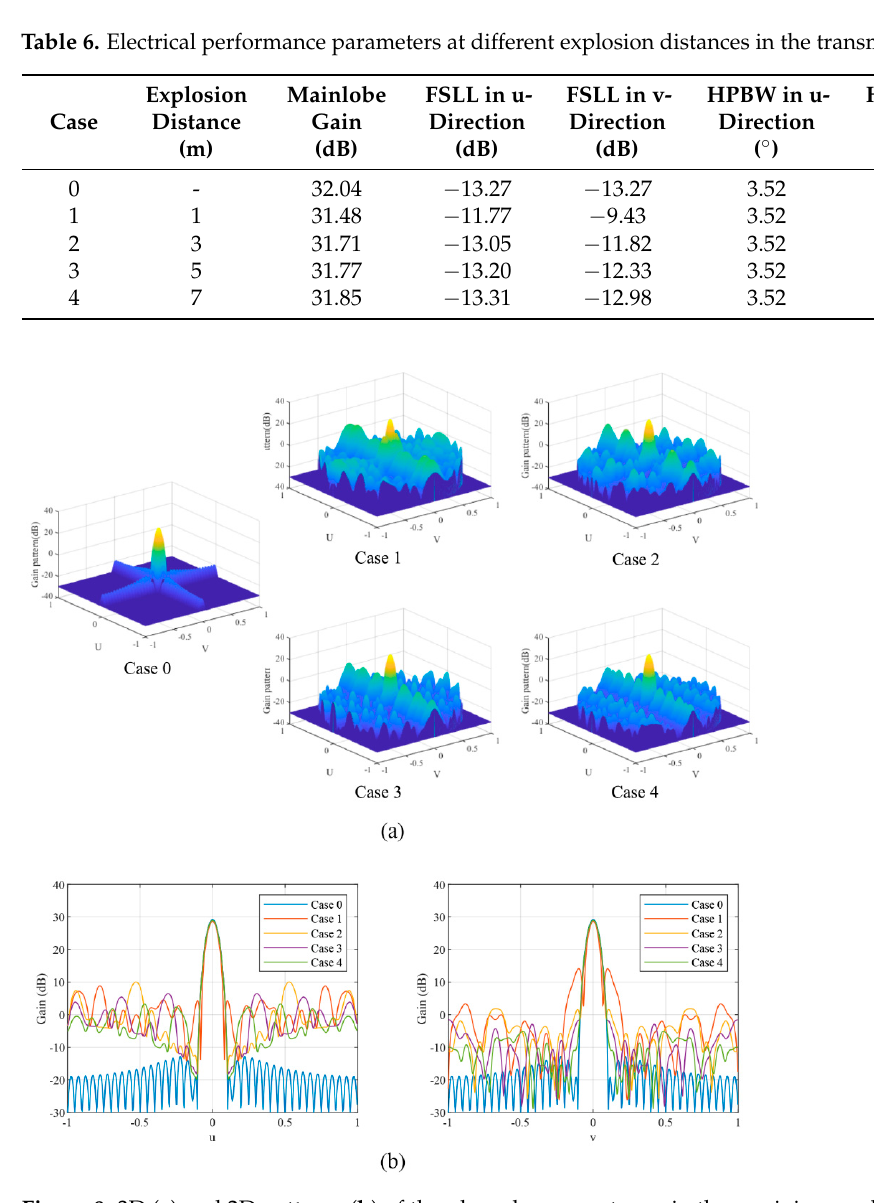
Figure 8. 3D ( a ) and 2D patterns ( b ) of the phased-array antenna in the receiving mode at different explosion distances.